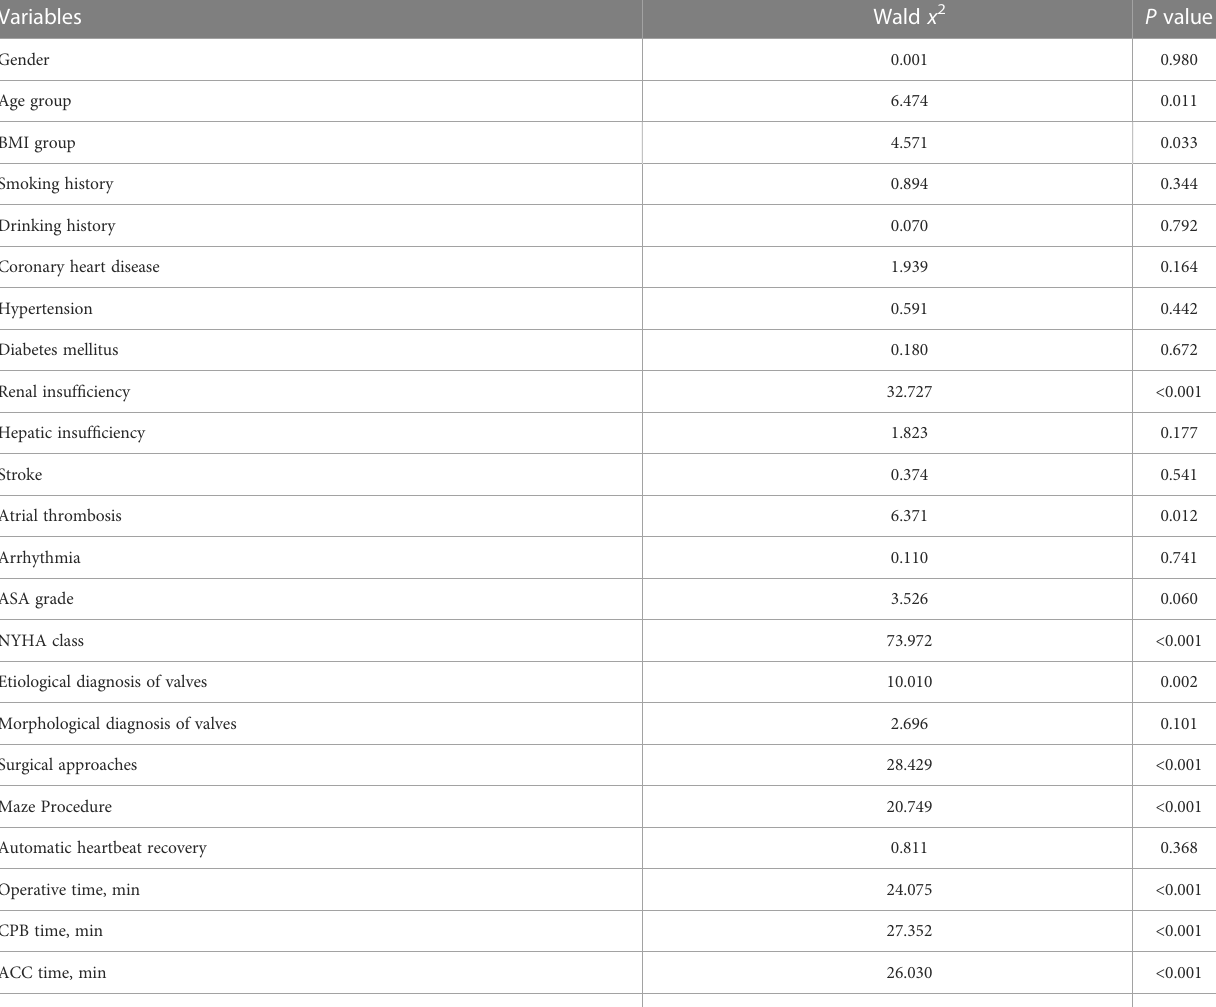
TABLE 2 Univariable analysis for postoperative BNP level >400